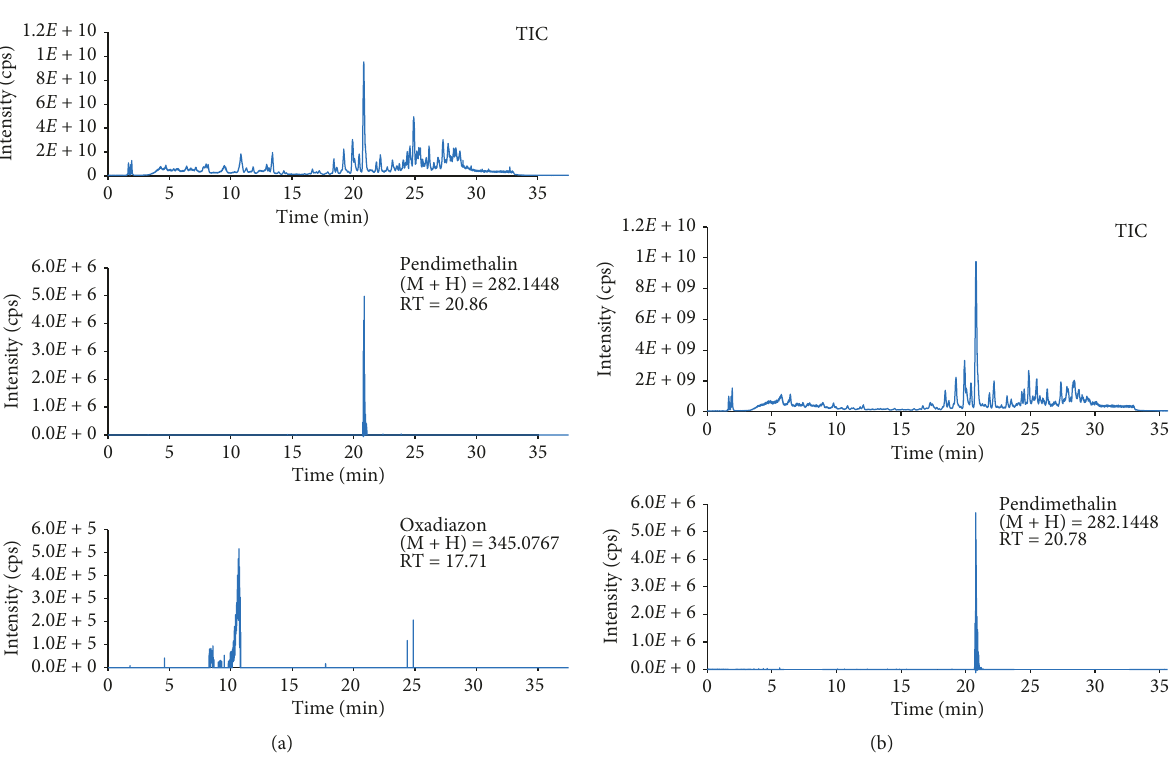
Figure 5: TIC and EICs of pesticides found in edible chrysanthemum (a) and green salad